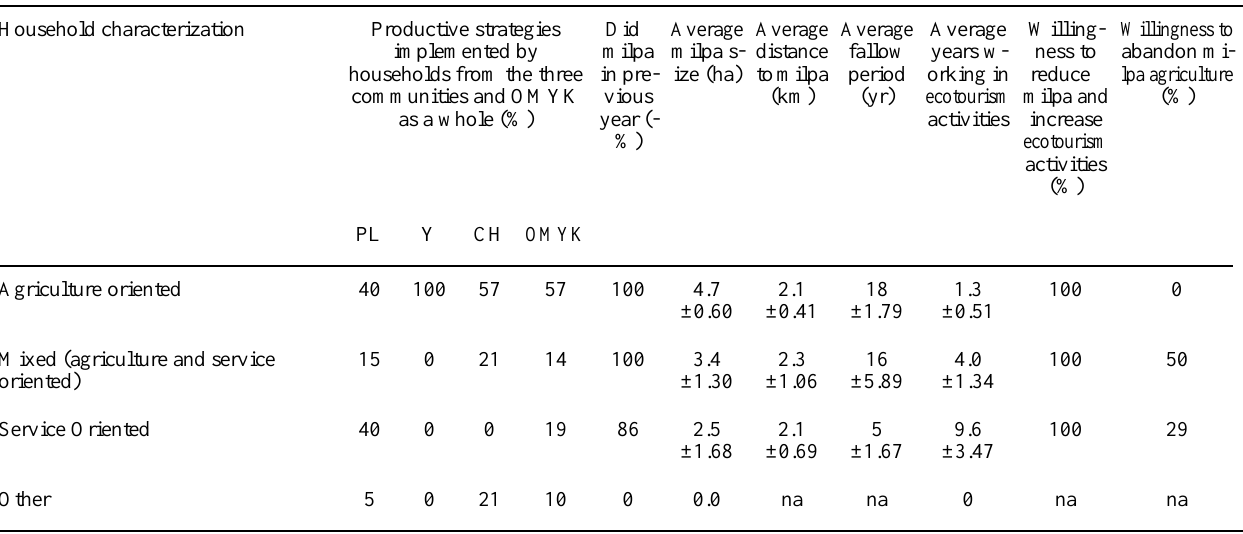
Table 1. Households’ implementation of milpa agriculture and management of ecotourism. Information is presented by households’ productive strategy. A 95% confidence interval is shown where averages are